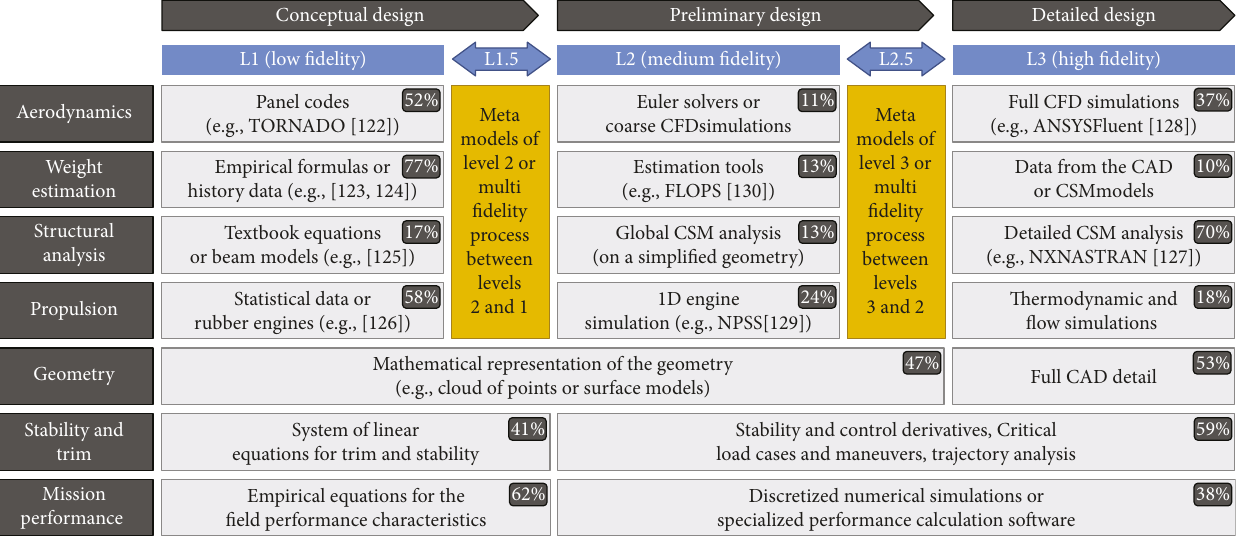
Figure 6: Example of the tools that are typically used in the disciplinary modeling of aerial vehicle